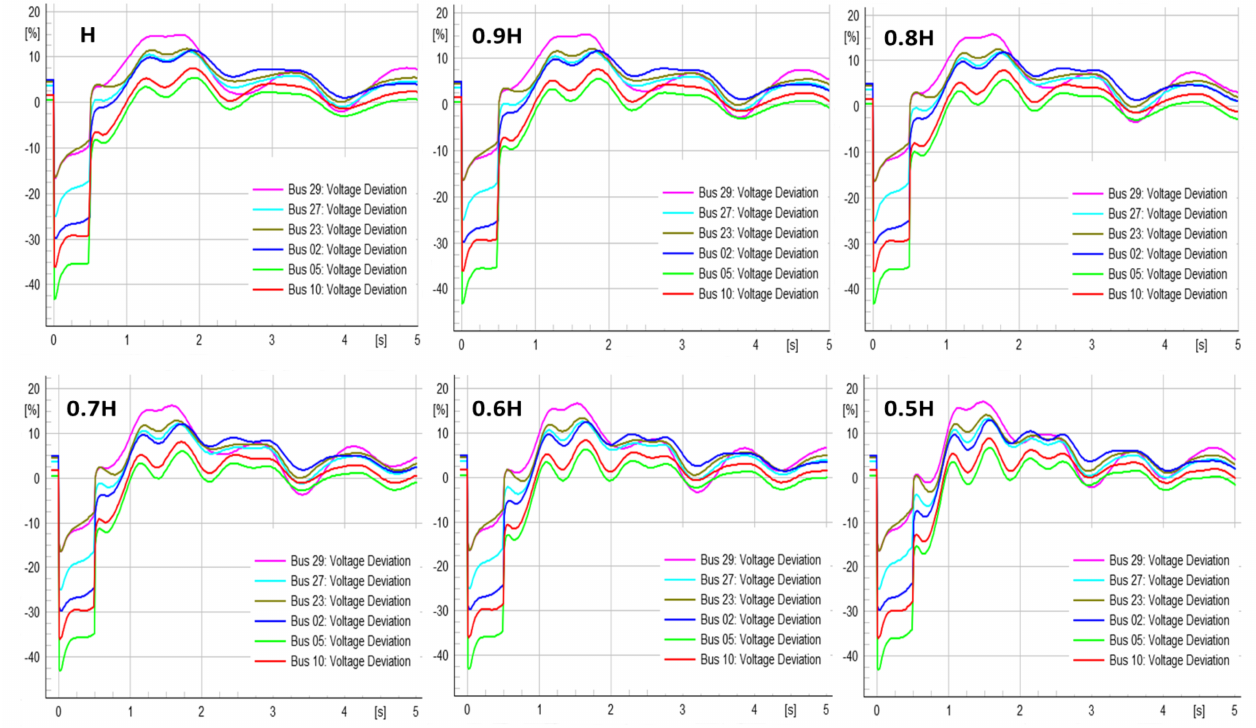
Figure 5. Voltage deviation (in %) at buses with different generator inertia